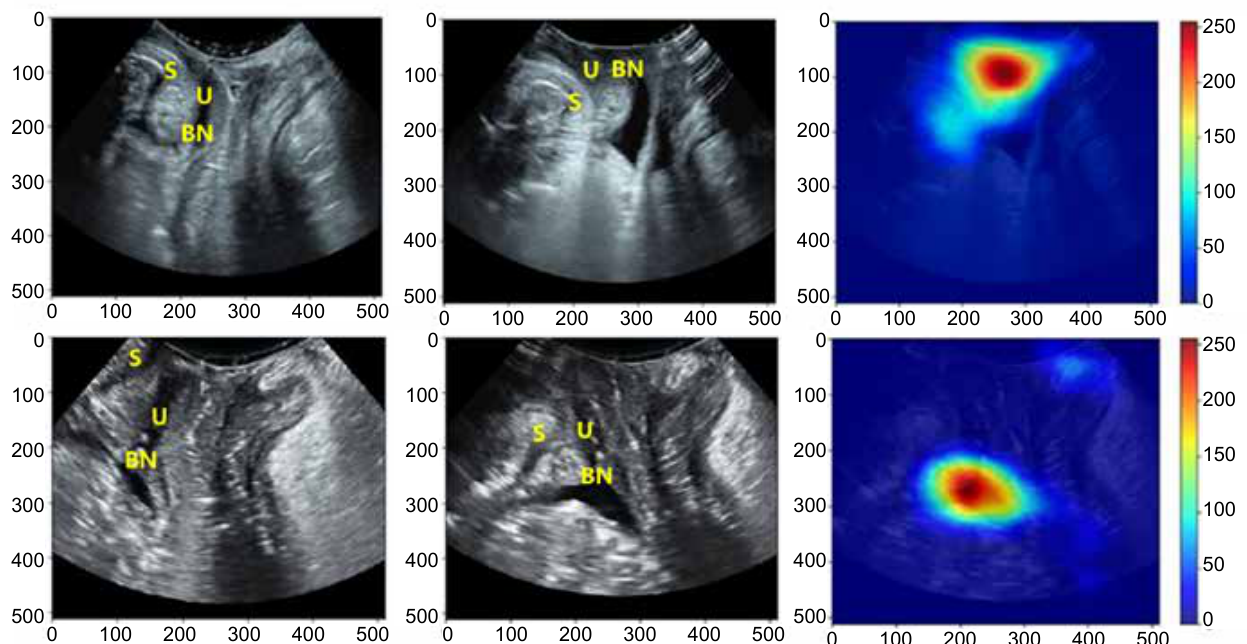
Figure 3C Schematics of gradient-weighted class activation mappings (Grad-CAMs). The highlighted areas indicated by the heat map are discriminative features for the identification of SUI from the testing data set. S, symphysis pubis; U, urethra; BN, bladder